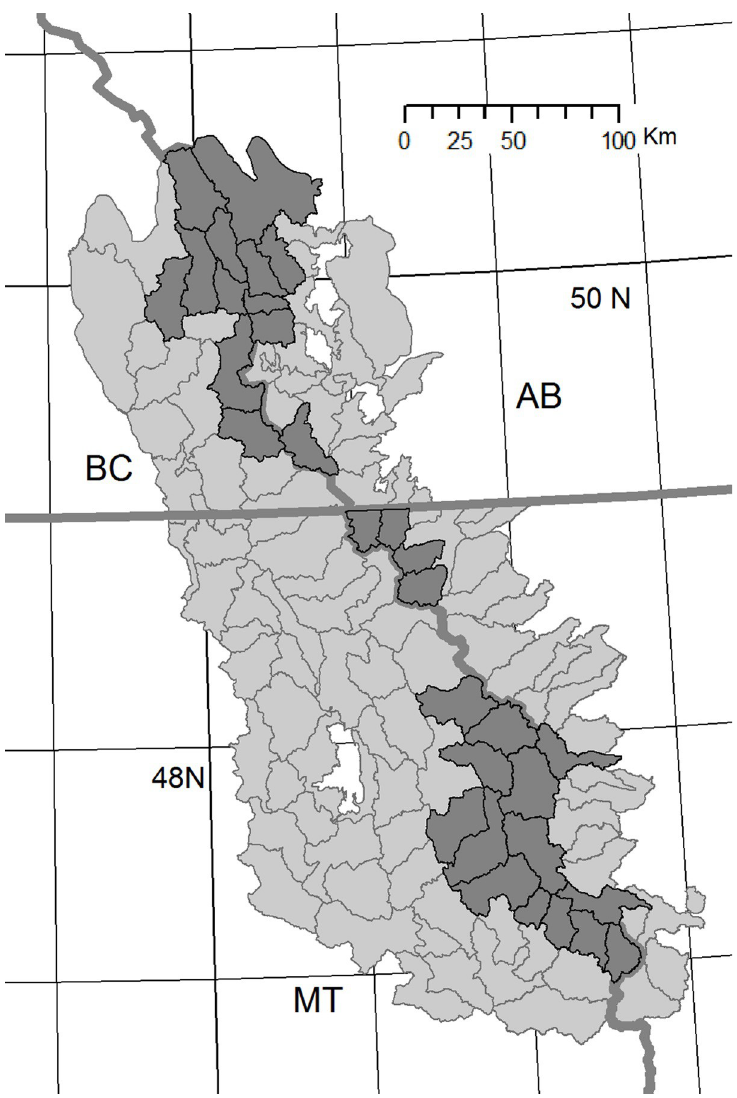
Fig 2. Highest mean elevation watersheds in the Crown of the Continent. Dark shaded watersheds indicate > 75 th percentile ranked watersheds based on mean elevation determined from the Crown Managers Partnership digital elevation model. Contains information licensed under the Open Government